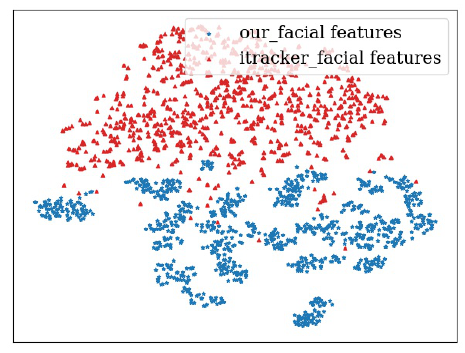
Figure 2. t-SNE [40] visualization of feature maps of the iTracker samples and